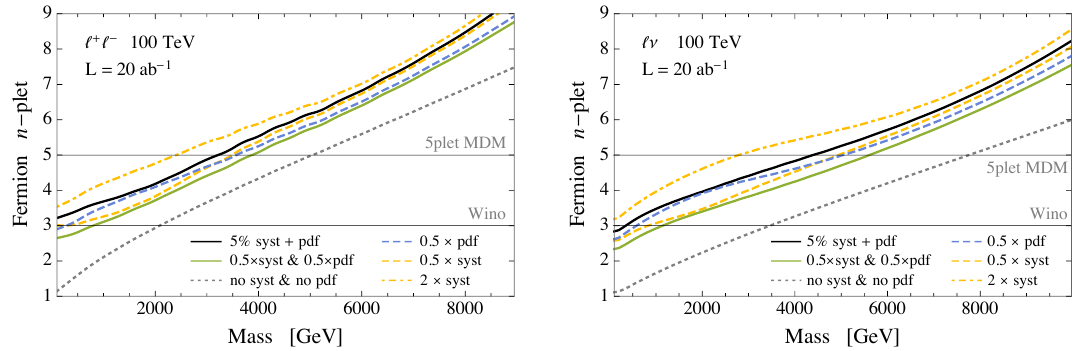
Figure 12 . Dependence of the 95% CL exclusion bounds on Majorana fermion multiplets at the FCC-100 on the PDF uncertainties and on the additional systematic